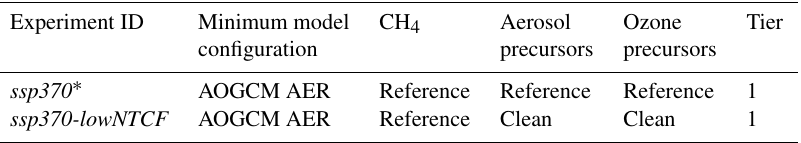
Table 4. List of future coupled-ocean experiments. Experiments cover the period 2015 to 2055. The “AER” suffix means models should at least calculate tropospheric aerosols driven by emission fluxes. Interactive chemistry should be active if available. Models should always be run with maximum complexity. The species columns refer to the specifications for concentrations (CH 4 ) or emissions (aerosol and ozone precursors). “Reference” means the concentrations or emissions should evolve as for SSP3-7.0; “Clean” means the concentrations or emissions should evolve following a version of SSP3-7.0 with cleaner air quality policies. CFC/HCFC concentrations should follow the SSP3-7.0 scenario in both cases. Three ensemble members are requested for each experiment.